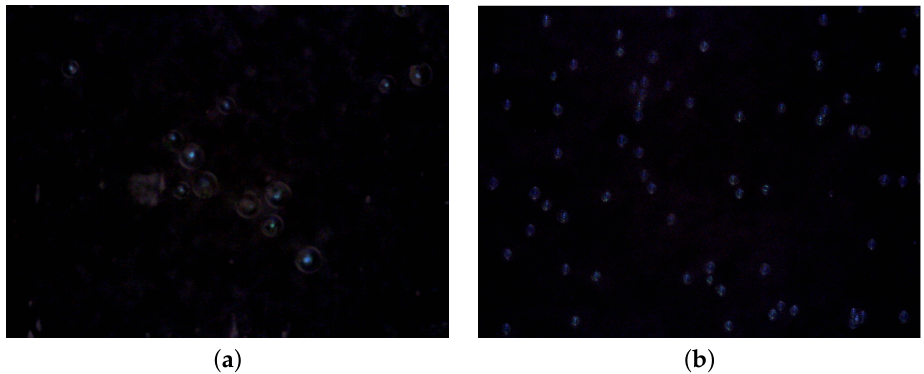
Figure 11. Images with low intra-distance: ( a ) one with not enough CSRs and, ( b ) one at low contrast and where our image processing fails to detect most of the